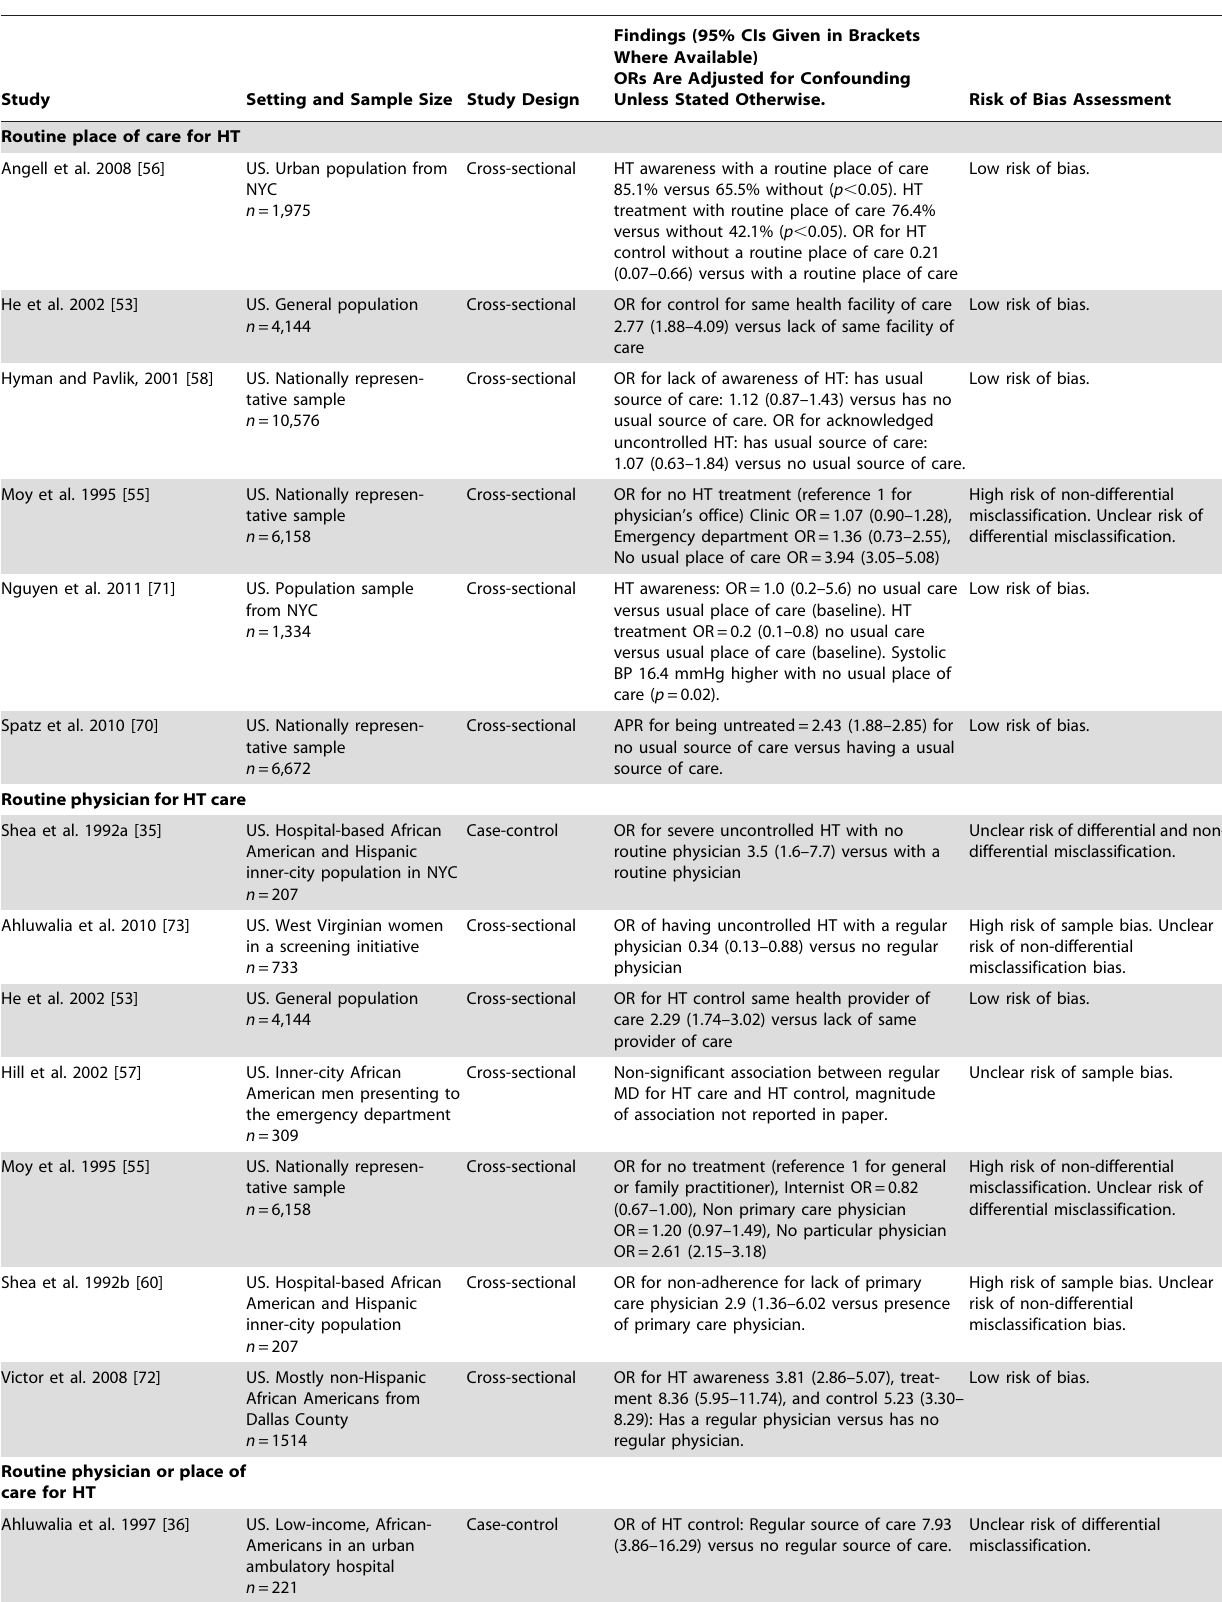
Table 6. Findings of studies examining health systems arrangements relating to health systems delivery and governance.